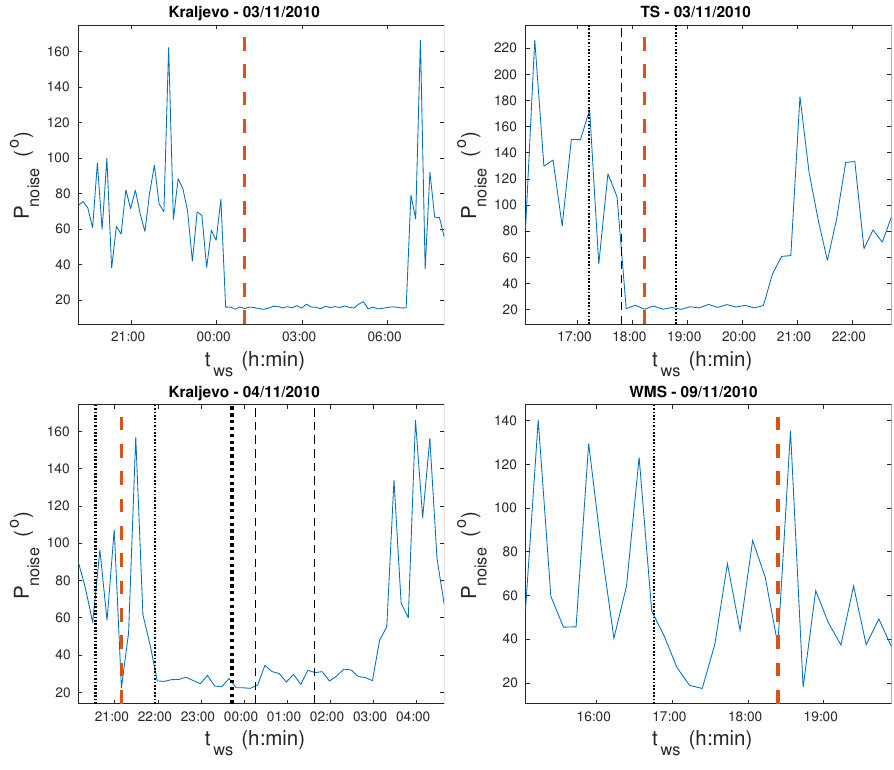
Figure 4. The same as in Figure 2 but for the phase noise P noise